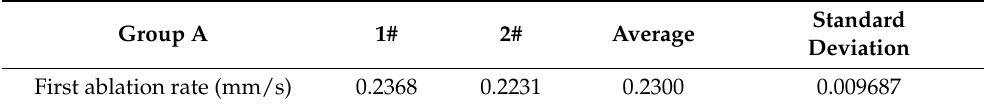
Table 6. The ablation rate after experiments.